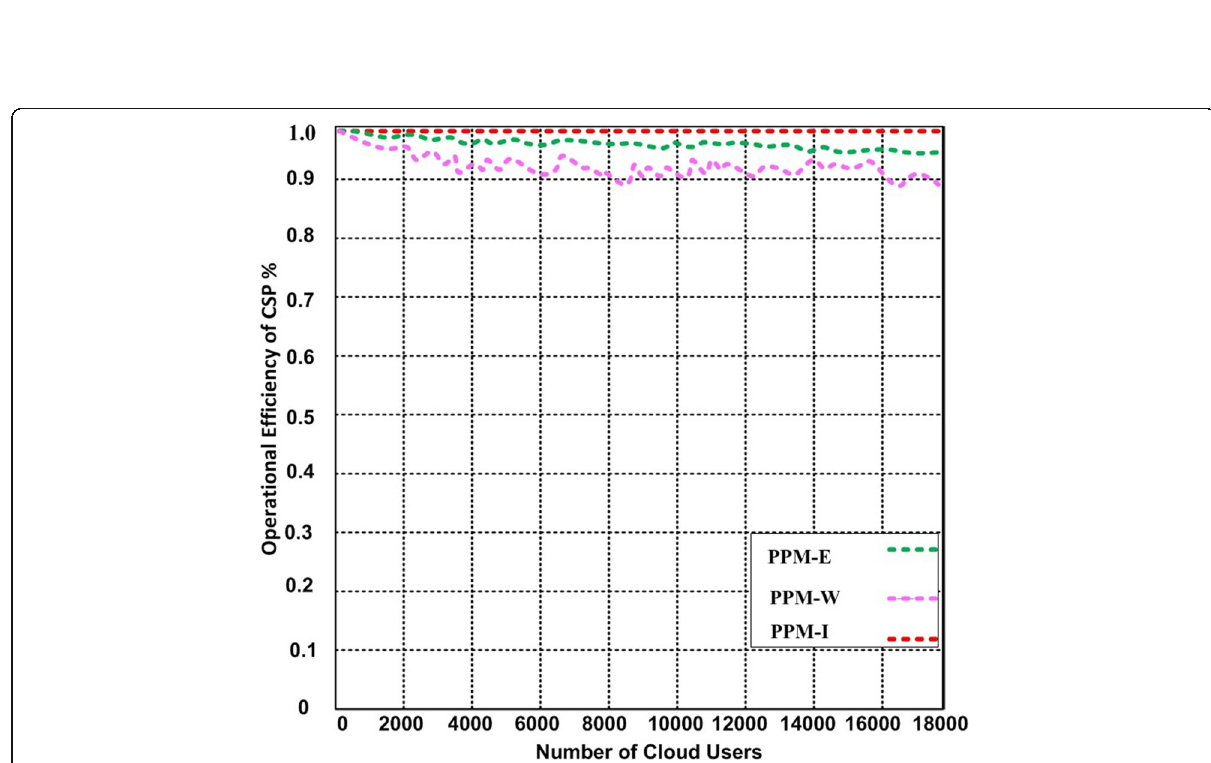
Fig. 10 Operational Efficiency VS number of cloud users (for a relatively larger cloud network)